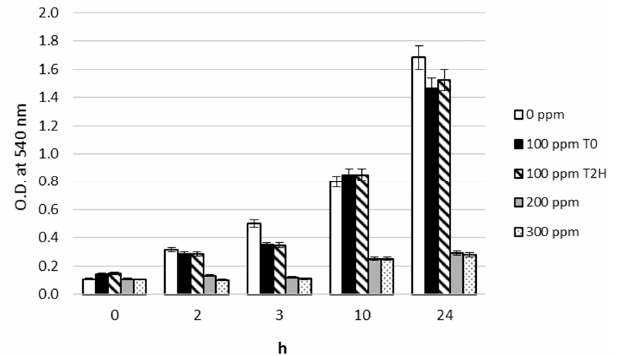
Figure 1. Lead effects on Thermus thermophilus growth. The microorganism was grown on media containing: 100 ppm, 200 ppm and 300 ppm of Pb 2+ , at different growth times. T 0 = Pb 2+ added at the beginning of incubation; T 2h = Pb 2+ added 2 h after the beginning of